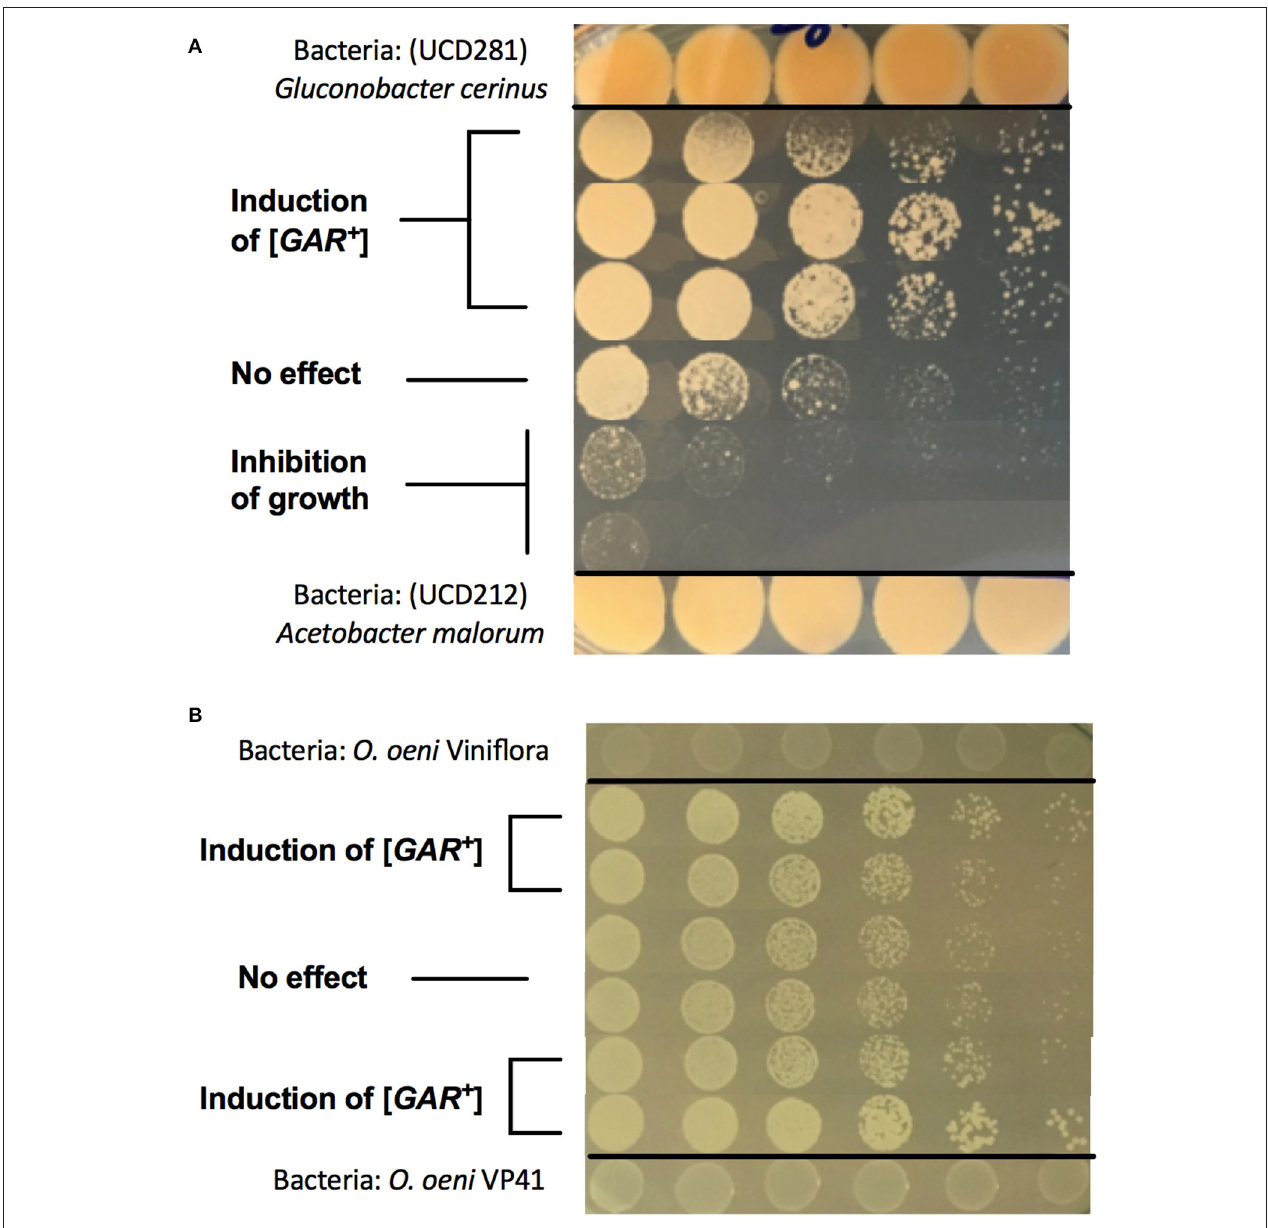
FIGURE 3 | Effect of Saccharomyces ecosystem bacteria on growth and induction of the [ GAR + ] prion. Growth of Gluconobacter cerinus (top) and Acetobacter malorum (bottom) adjacent to [ gar − ] Saccharomyces UCD932 strain on GGM media induces and inhibits growth respectively (A) . Both strains of Oenococcus oeni adjacent to [ gar − ] Saccharomyces UCD932 strain induce growth of yeast on GGM media (B) . Spot assays represent five-fold serial dilutions.